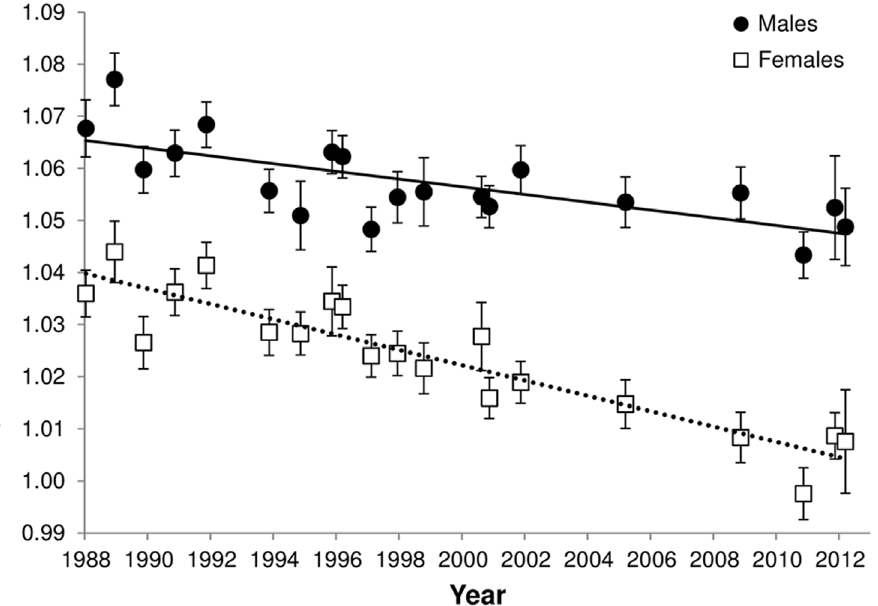
Figure 3. Body condition in adult male and female tuatara. Fitted body condition estimates (log mass/log snout-vent length 6 1 SE) show declines for both male and female tuatara on North Brother Island from 1988 to 2012. The rate of decline for adult female body condition was found to be greater than the decline in adult males.